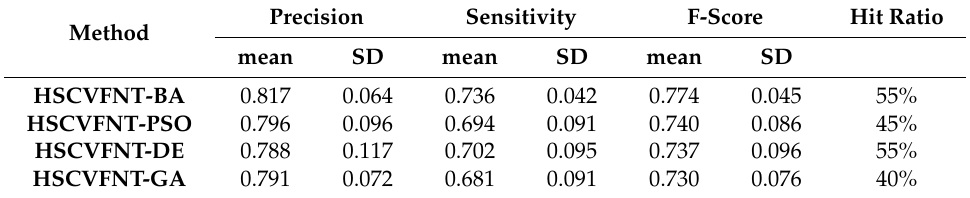
Table 5. Comparison of four methods for IRMA network inference with on dataset.